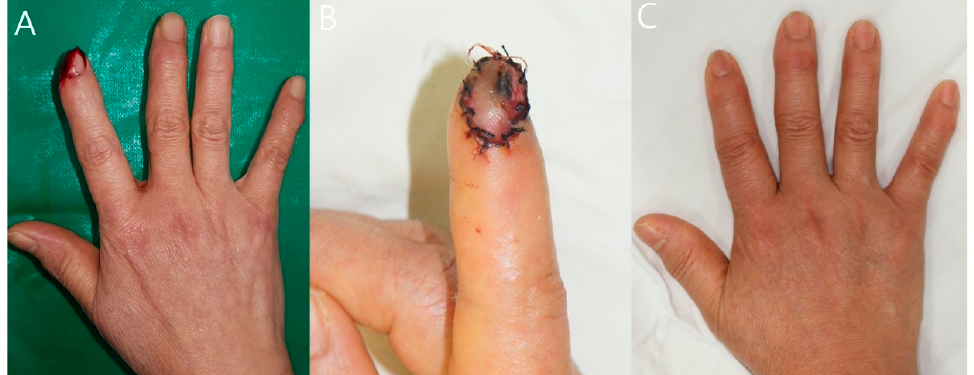
Figure 3. Case 2 (patient 12). ( A ) A 61-year-old patient with an amputated right index finger. ( B ) The tie-over dressing was removed on postoperative day 7. The stump was well maintained. ( C ) Nine months postoperatively, the patient did not complain of any functional complications.